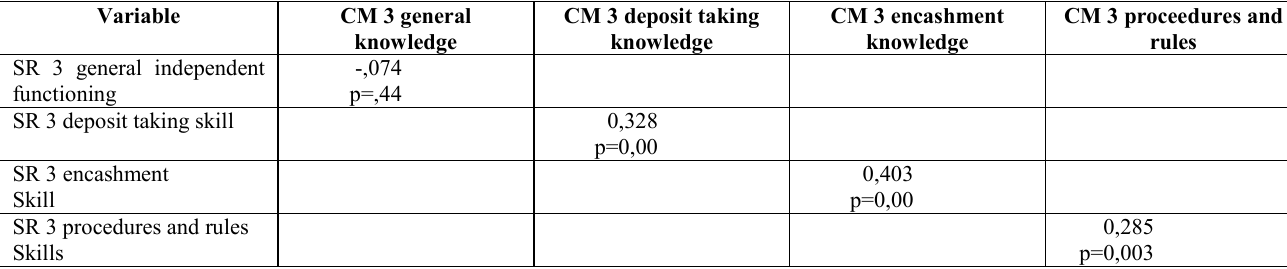
Table 4: Correlations between supervisory ratings and knowledge